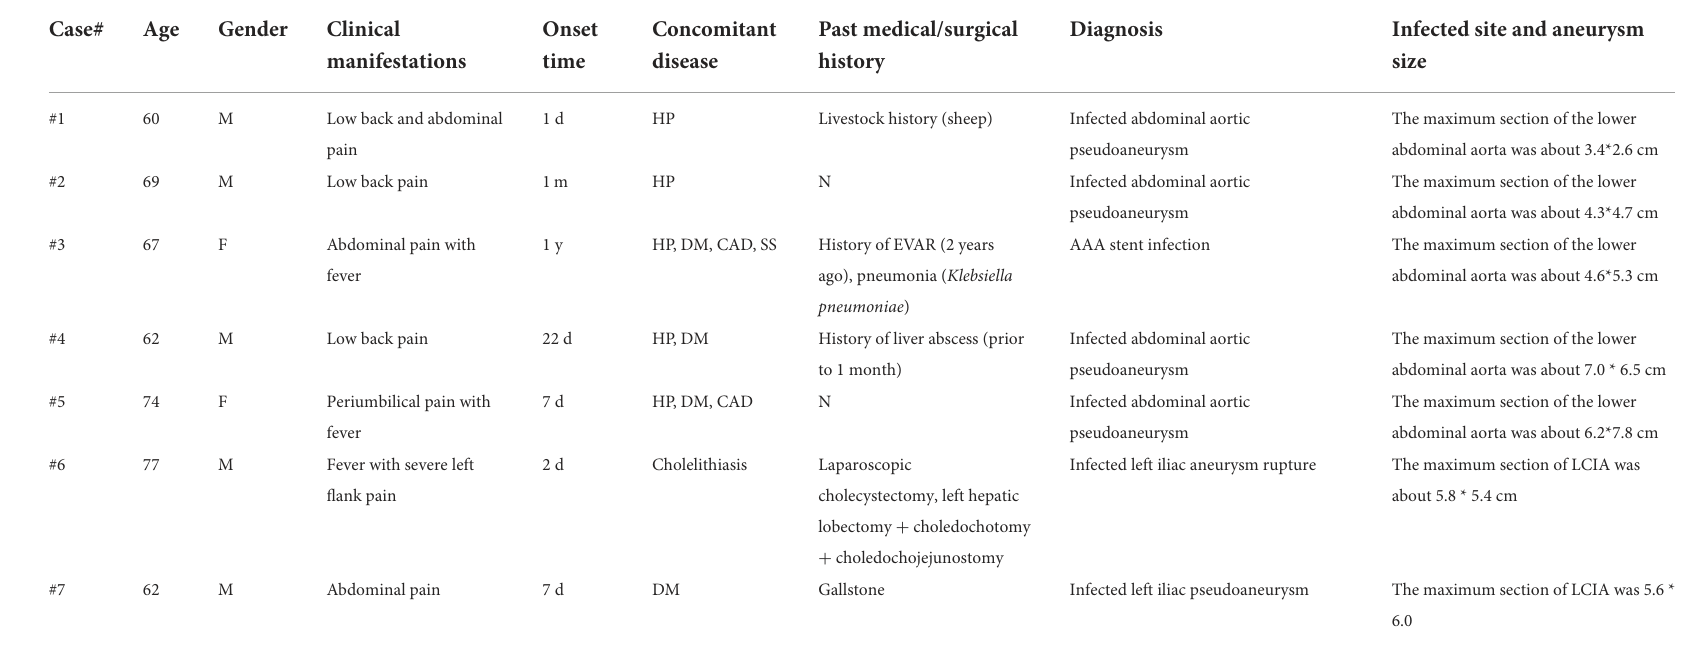
TABLE 1 General information of